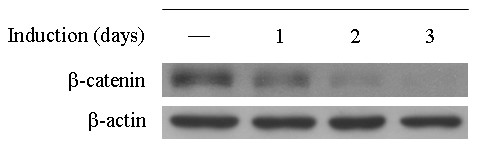
Reduction of β-catenin expression in stable pTER transfectants. Exponentially proliferating HeLaT-β-catenin-RNAi cells were treated with DOX and whole cell lysates were prepared at the time points indicated. Total cell lysates were separated by SDS-PAGE and immunoblotted with an antibody to β-catenin, expression levels were normalized for loading by probing for β-actin.